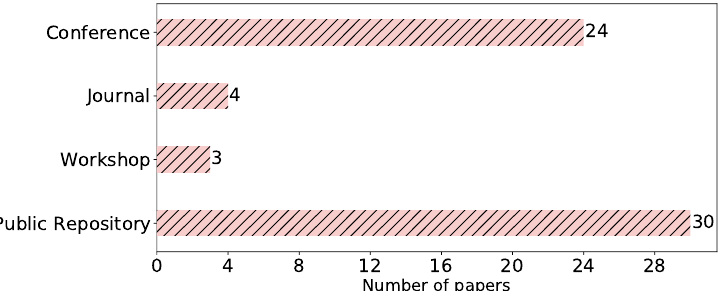
Figure 5. Venue types of the selected papers.